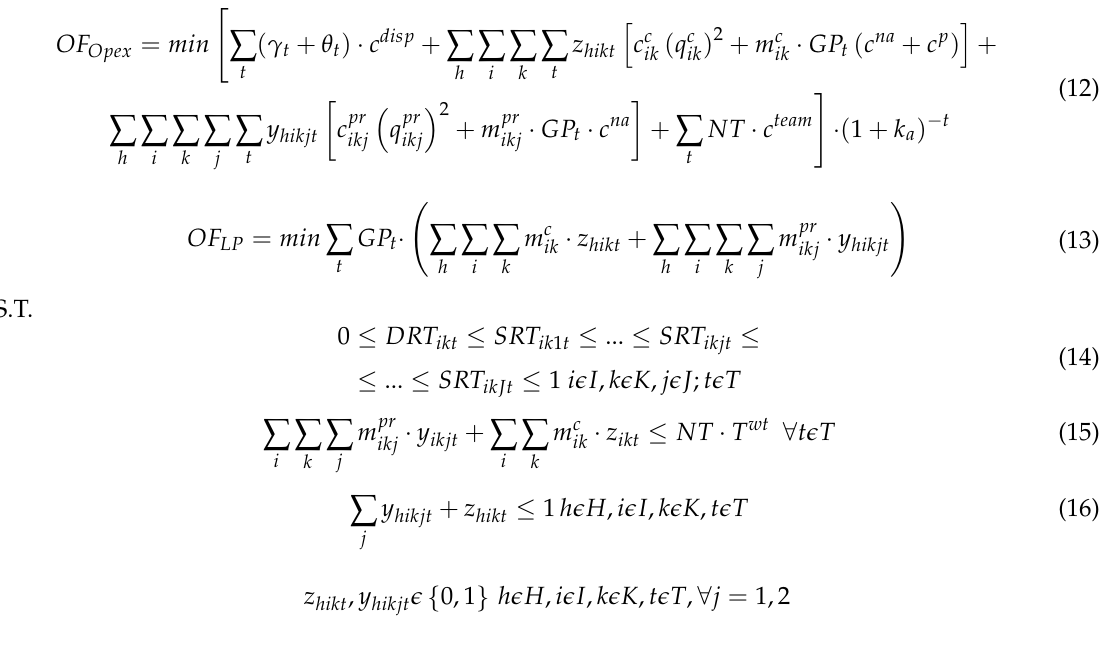
Table 2. Intermediate binary variables used in the